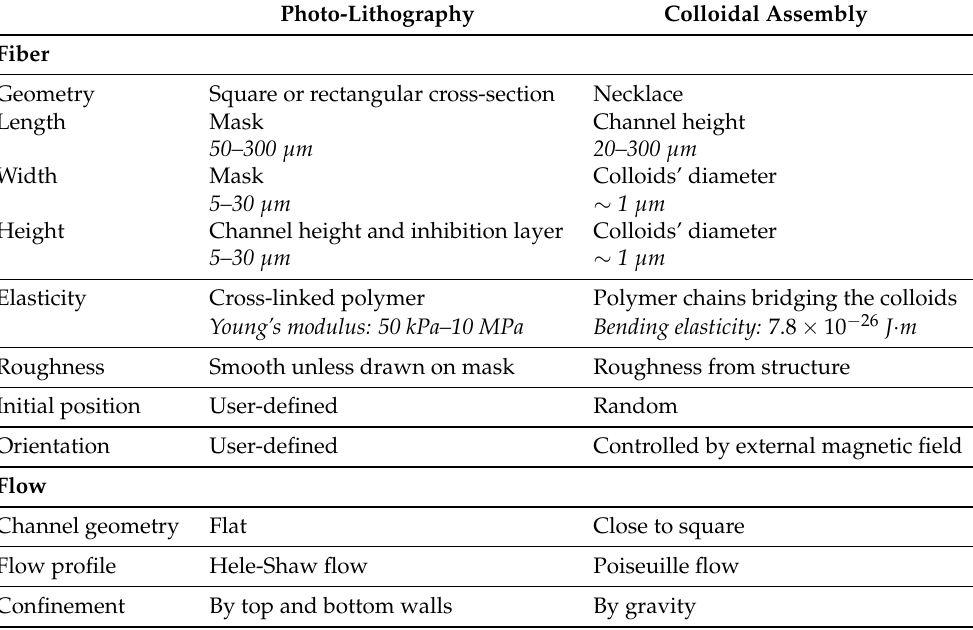
Table 1. Comparison of the two micro-fiber fabrication methods. Typical dimensions are given in